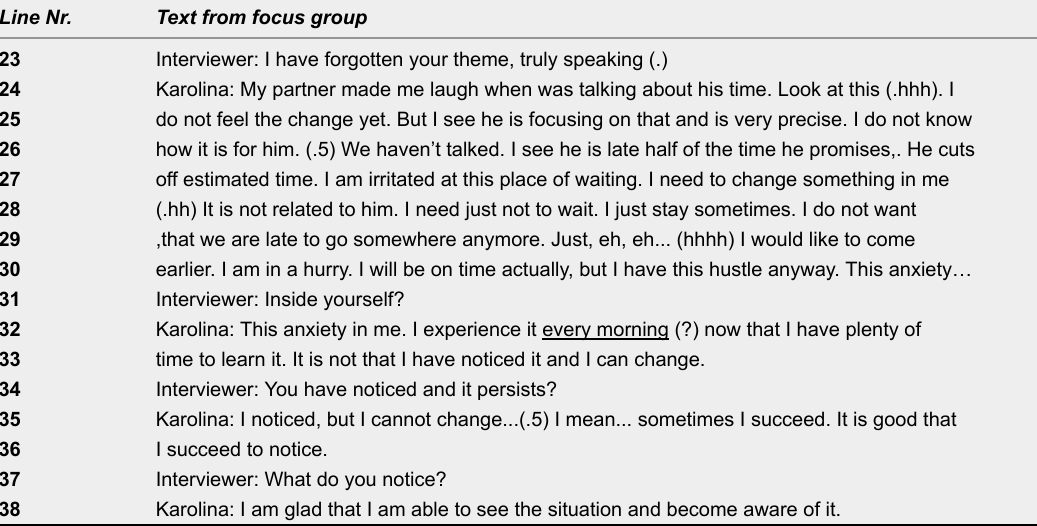
Example of the Theme “Recognising One’s Own Feelings and Taking Responsibility for Them.” Text from focus groupLine